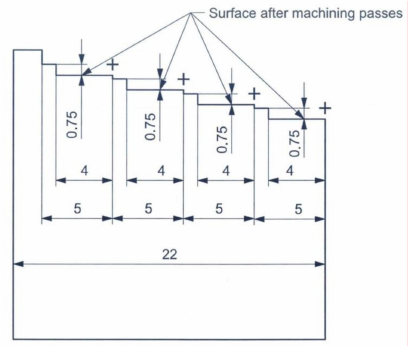
Figure 1. Drawing for workpiece illustrating machining passes, (all dimensions are in mm).